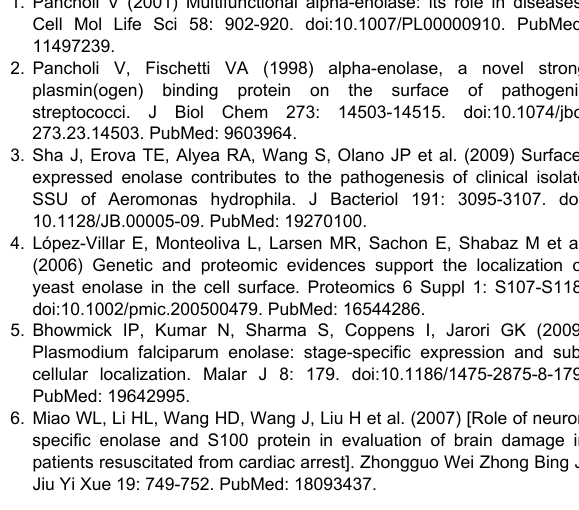
List of proteins identified in food vacuole preparation made from P. yoelii as described in Materials & Methods.